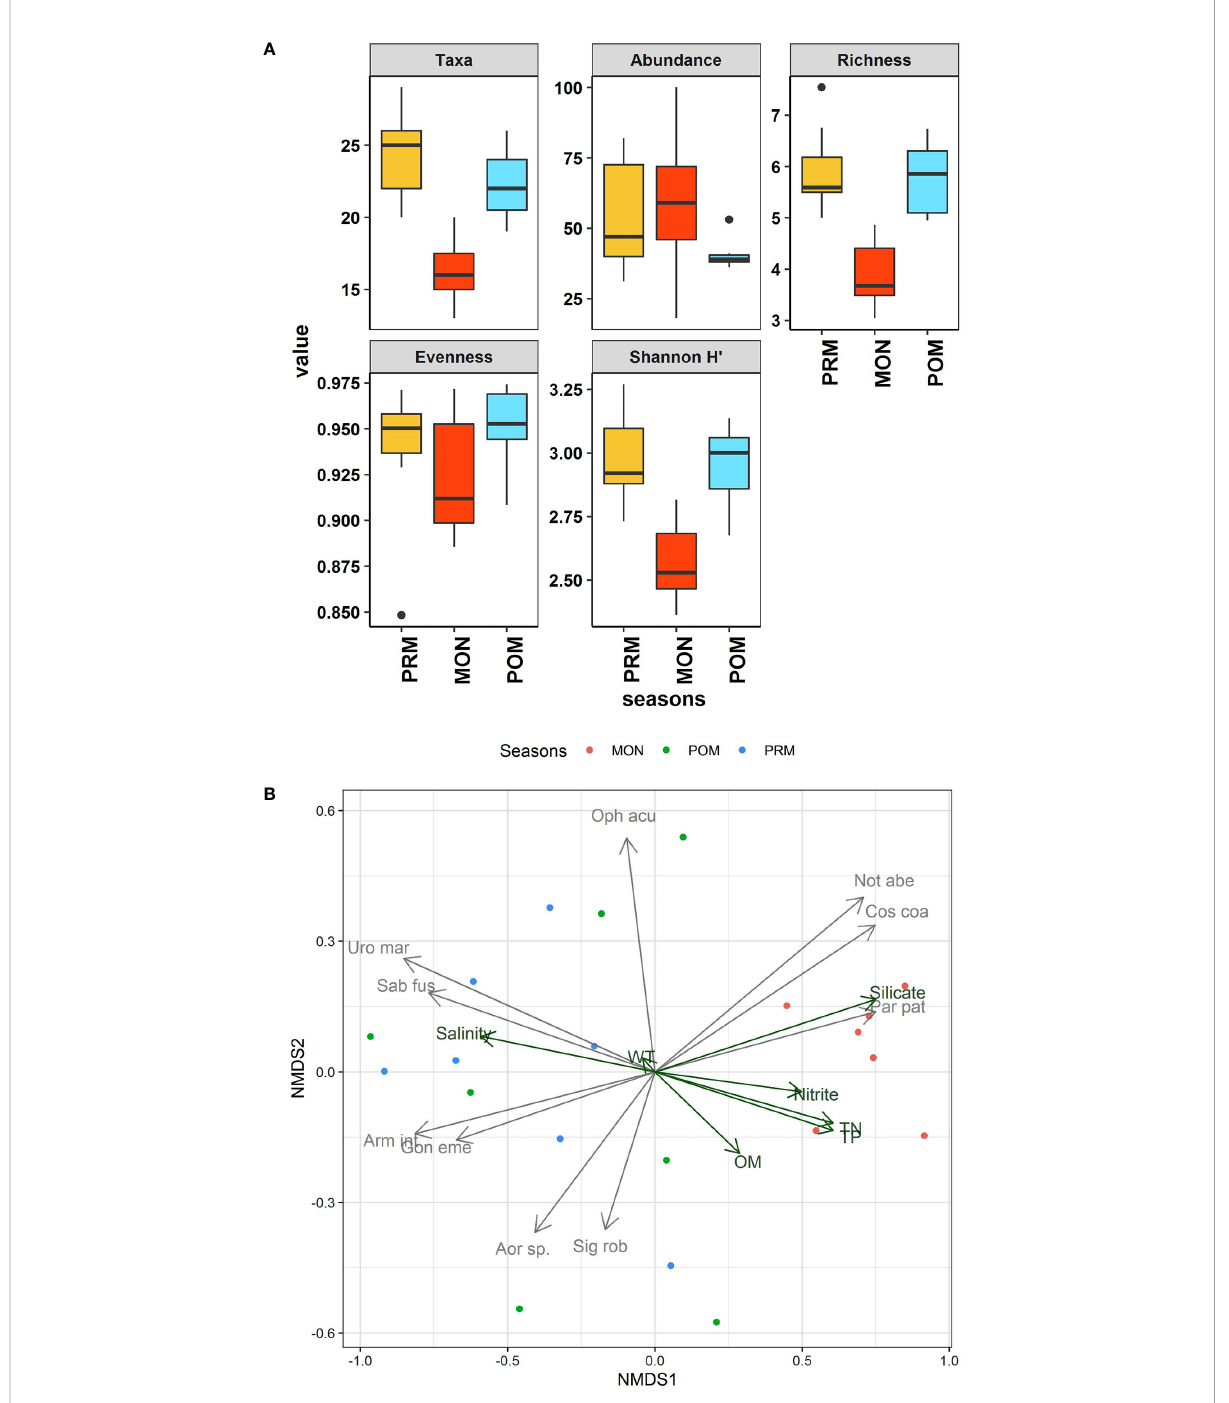
FIGURE 2 (A) Box plots showing the variations in community characteristics of macrobenthic fauna during different season. In each boxplot, the central line represents the median, the rectangle gives the interval between 25% and 75% percentiles, whiskers indicate the range and black dots represent outliers. Abundance is represented as ind/0.02m 2 . (B) NMDS ordination of the correlation between the macrofaunal community composition and the best subset of environmental variables and taxa with maximum correlation with community dissimilarities plotted as vectors. The vectors represented in green correspond to environmental variable whereas grey vectors represent taxa (abbreviation as per Table